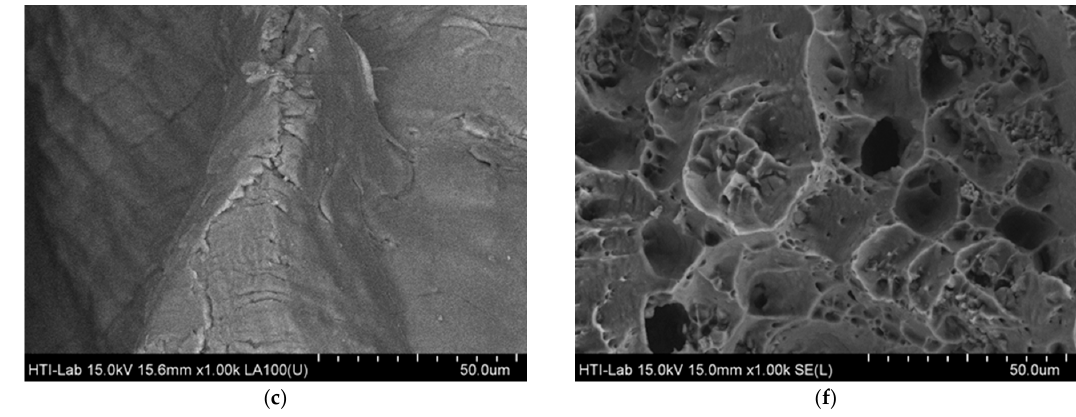
Figure 6. FESEM micrographs showing the fracture surface of minimum–maximum parameter S1-T1 (430 °C/60 min) and S9-T1 (530 °C/120 min): ( a ) S1-T1 (430 °C/60 min); ( b ) S1-T1 (430 °C/60 min); ( c ) S1-T1 (430 °C/60 min); ( d ) S9-T1 (530 °C/120 min); ( e ) S9-T1 (530 °C/120 min); and ( f ) S9-T1 (530 °C/120 min).